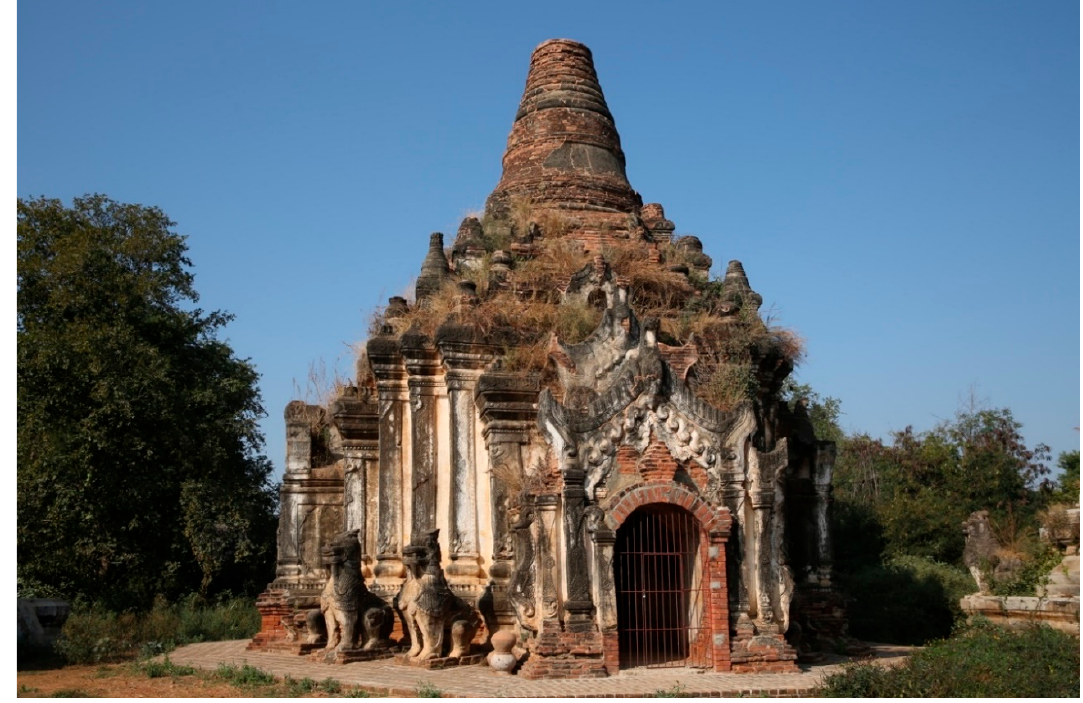
Figure 6. Anaint, 18th century.